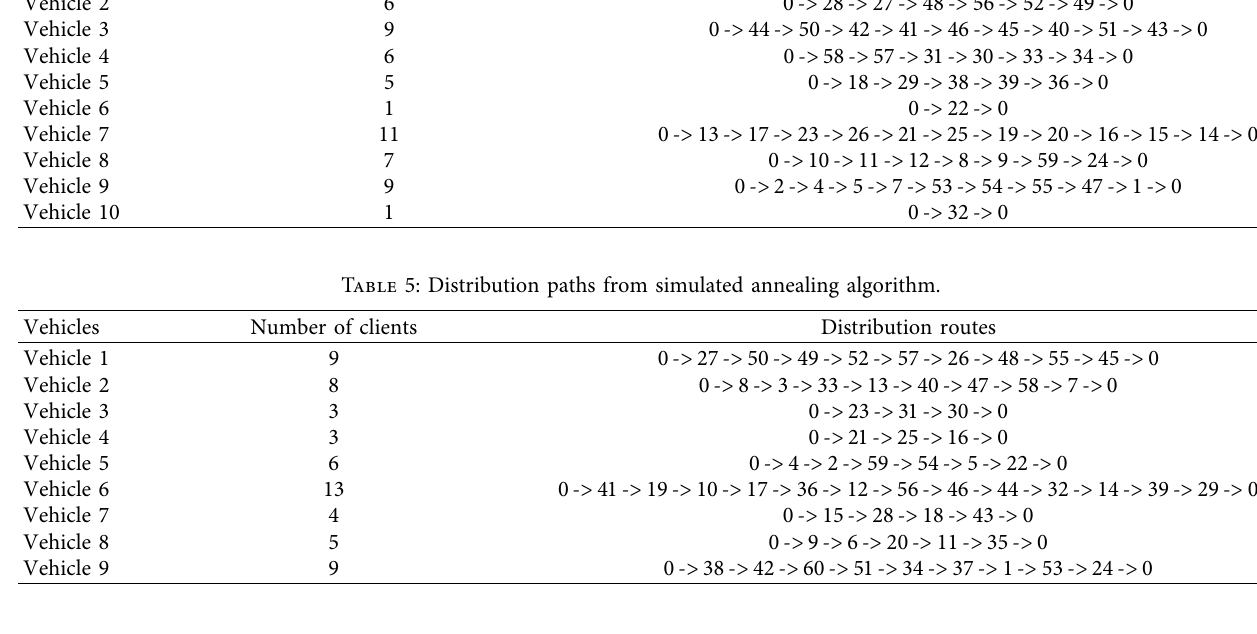
Table 6: Distribution paths by the simulated annealing-genetic hybrid algorithm.